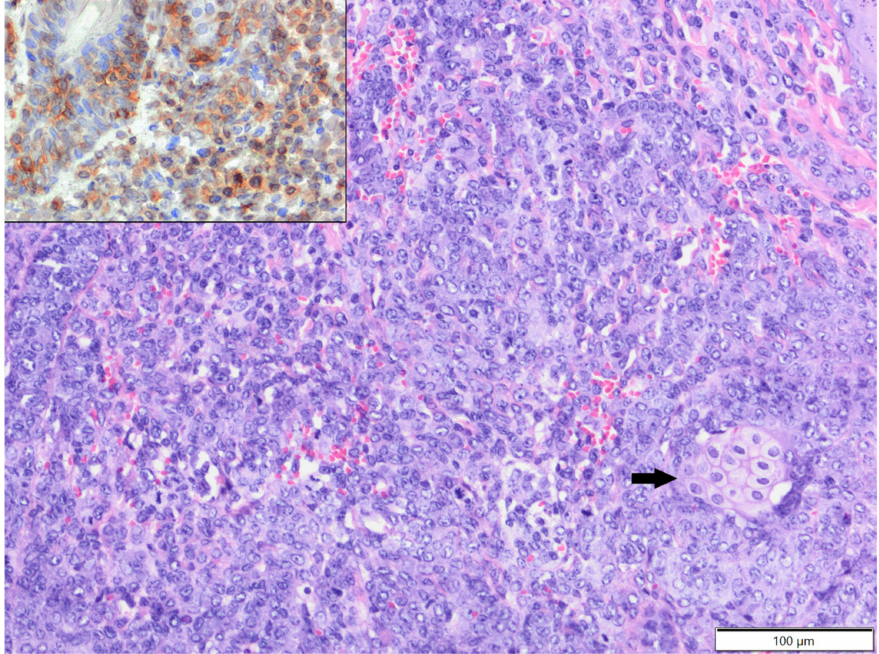
Figure 4. T-cell epitheliotropic lymphoma, tail, golden hamster. Large lymphocytes massively infiltrated the skin and adnexa, and there is a single entrapped sebaceous gland visible (arrow). HE. Inset: tumour cells show expression of CD3.